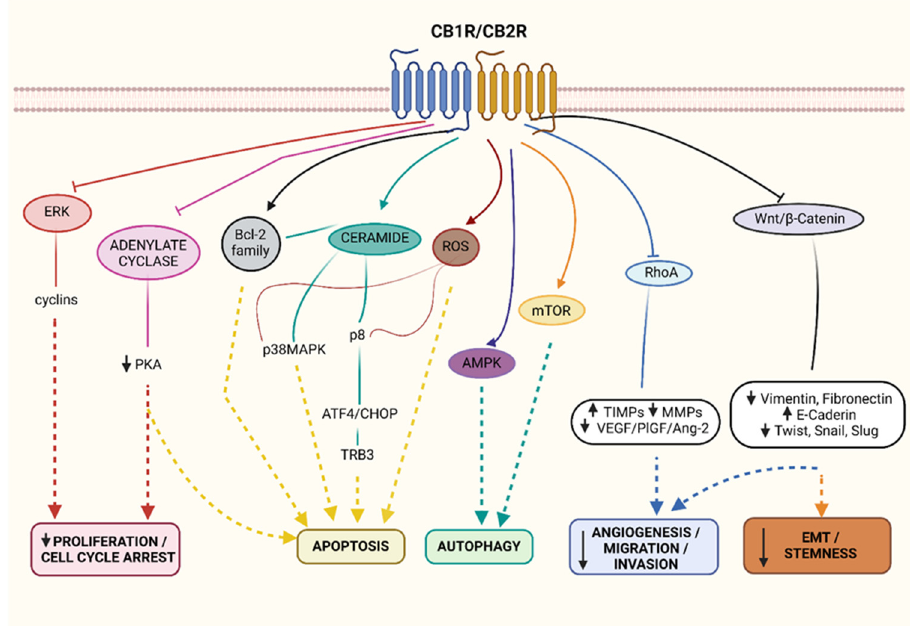
Figure 2. Canonical CBRs signalling in cancer. Cannabinoids inhibit proliferation and cell cycle ( ↓ ERK/cyclins; ↓ Adenylate cyclase/PKA), induce apoptosis ( ↑ Bcl-2; ↑ p38MAPK; ↑ p8/ATF4/CHOP/TRB3; ↑ ROS) and autophagy ( ↑ AMPK; ↑ mTOR), decrease angiogenesis ( ↓ VEGF/PIGF/Ang-2), migration and invasion ( ↓ RhoA; ↓ MMPs). The modulation of CB1R/2 also reduce EMT ( ↓ Vimentin, Fibronectin) and stemness ( ↓ Wnt/ β -catenin; ↓ Twist, Snail and Slug). Created with